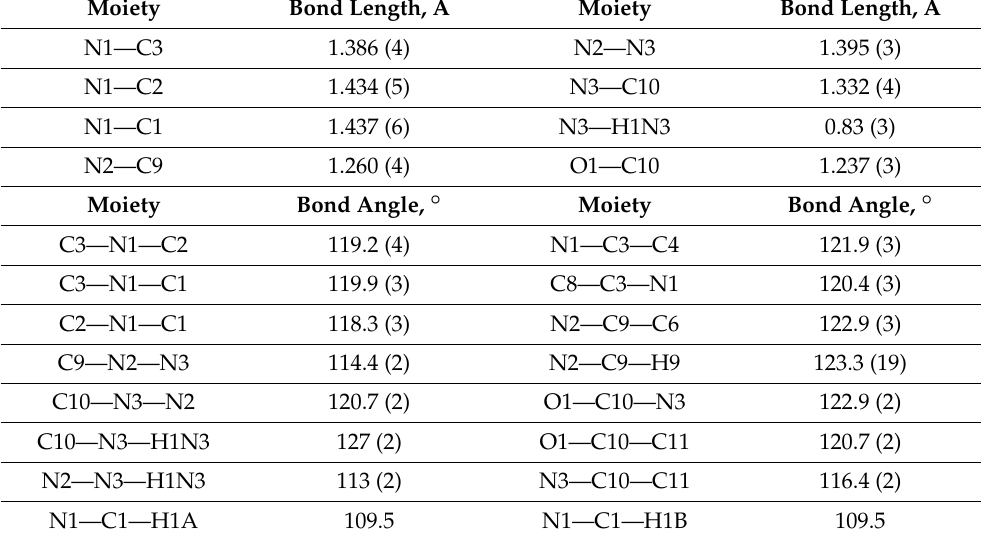
Table 5. Selected bond lengths (Å) and bond angles ( ◦ ) of compound 14 .